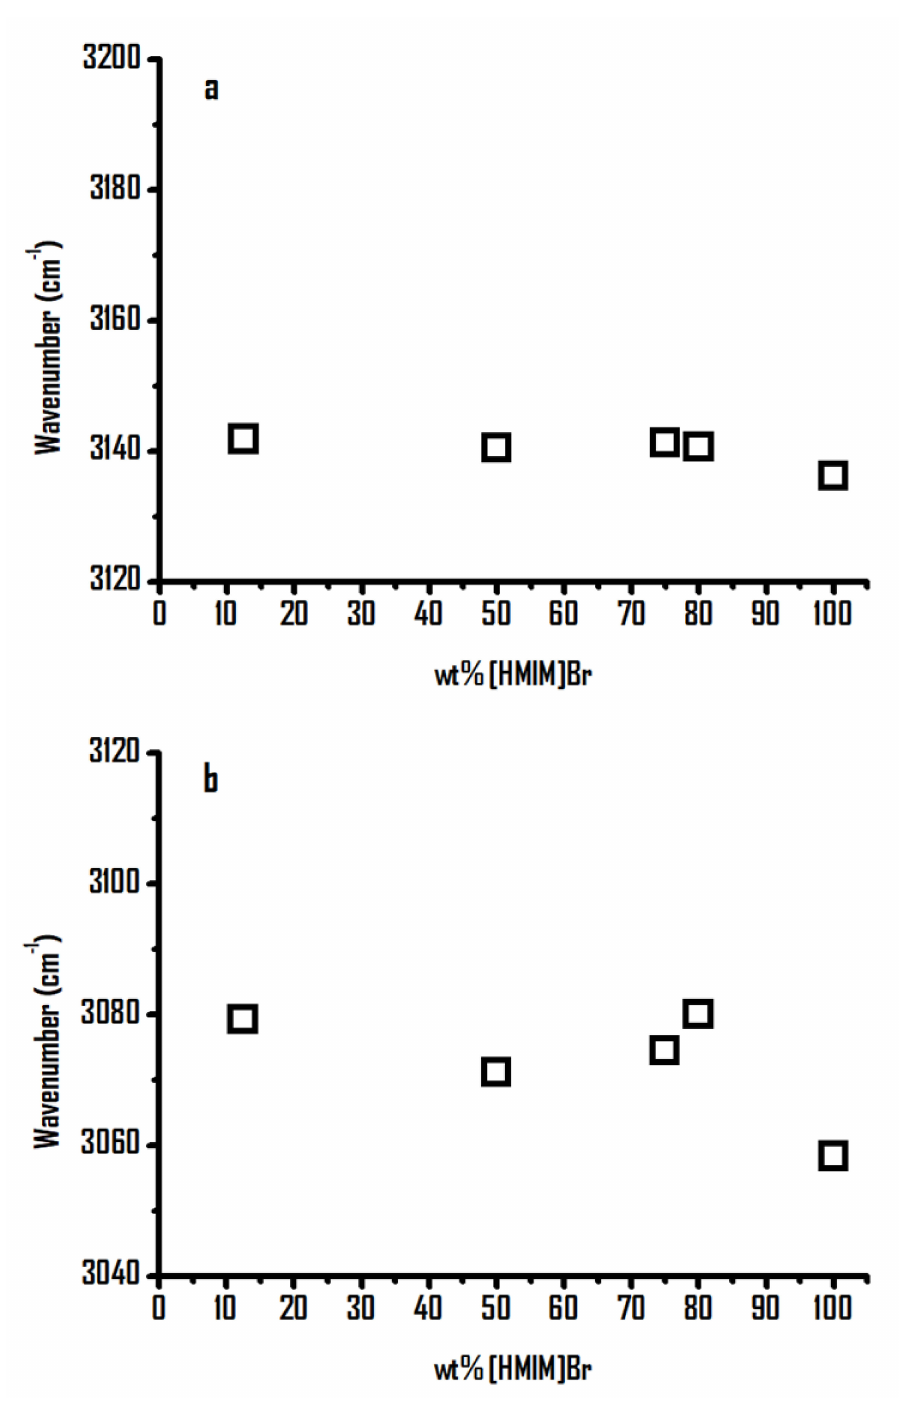
Figure 7. Concentration dependence of ( a ) imidazolium C 4,5 –H and ( b ) imidazolium C 2 –H stretching bands of [HMIM]Br-PEO mixtures as a function of the weight percentage of